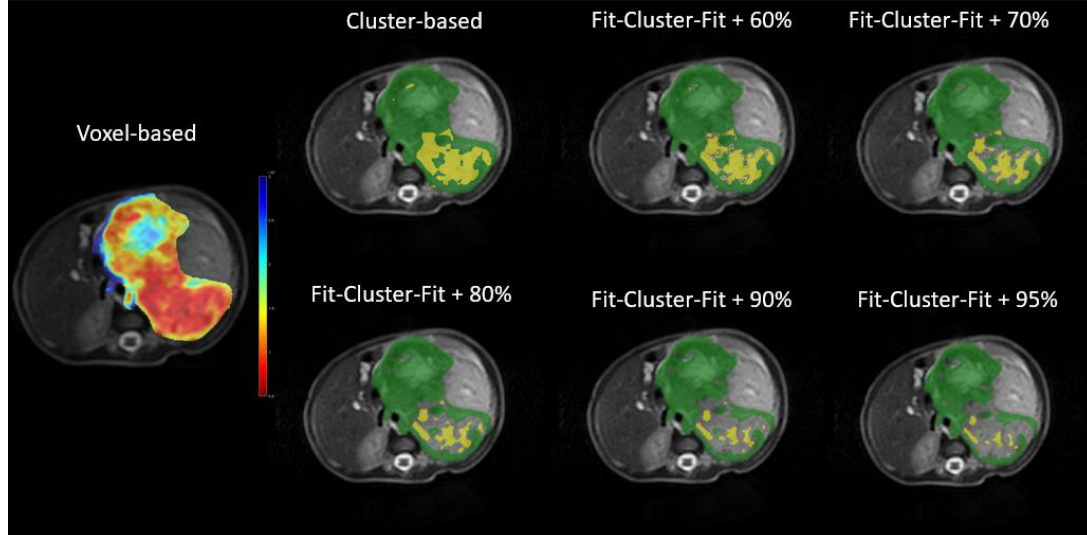
Figure 4. Parametric ( left ) and representative ( right ) maps of the apparent diffusion coefficient (ADC) in the voxel-based, cluster-based and Fit-Cluster-Fit models at different confidence thresholds for uncertainty exclusion (60%, 70%, 80%, 90% and 95%). The ranges established were: parametric maps, red (0.5·10 −3 mm 2 /s)–blue (3.0·10 −3 mm 2 /s); and representative maps, yellow (lower ADC habitat)–green (higher ADC habitat).